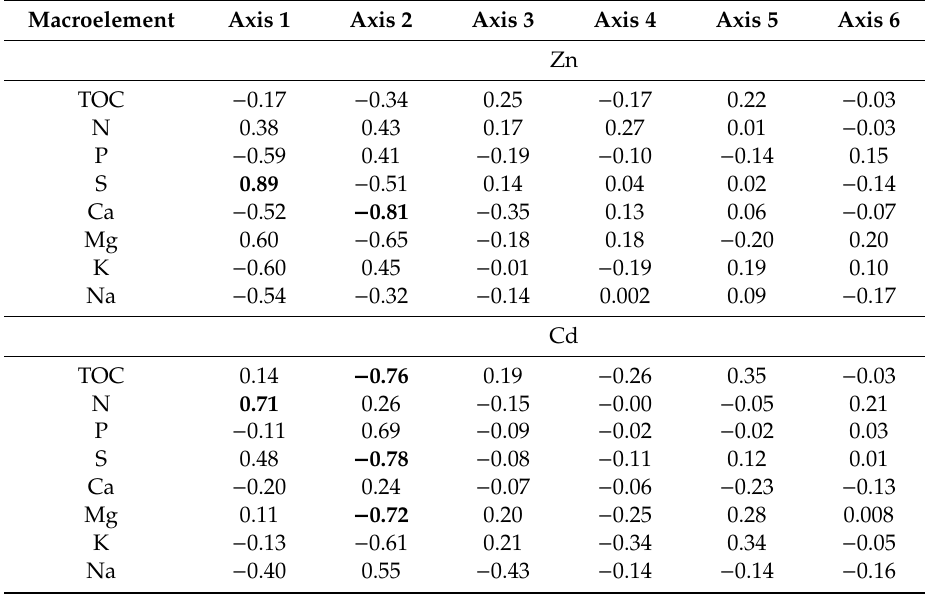
Table 7. Results of factor loads obtained on the basis of CCA analysis. Loads with high values > 0.7 are